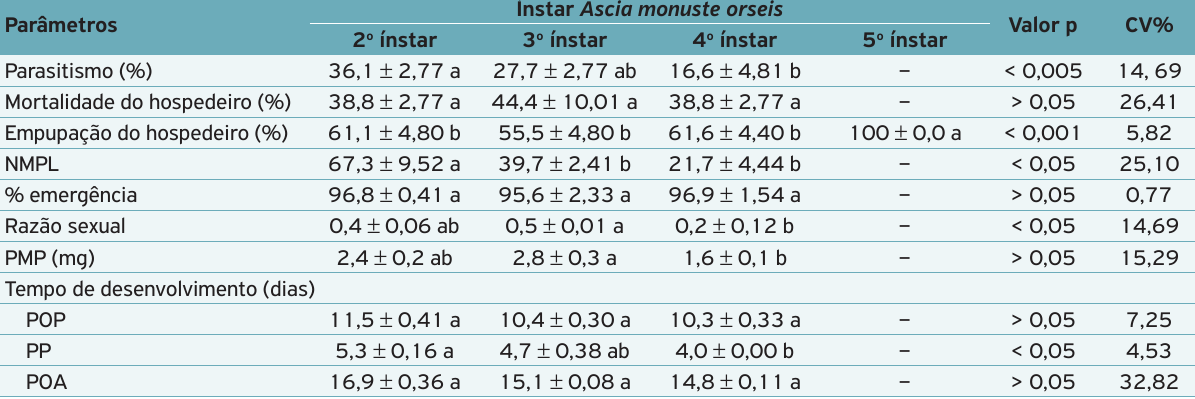
Tabela 2. Desempenho de Cotesia glomerata parasitando diferentes ínstares de Ascia monuste orseis.